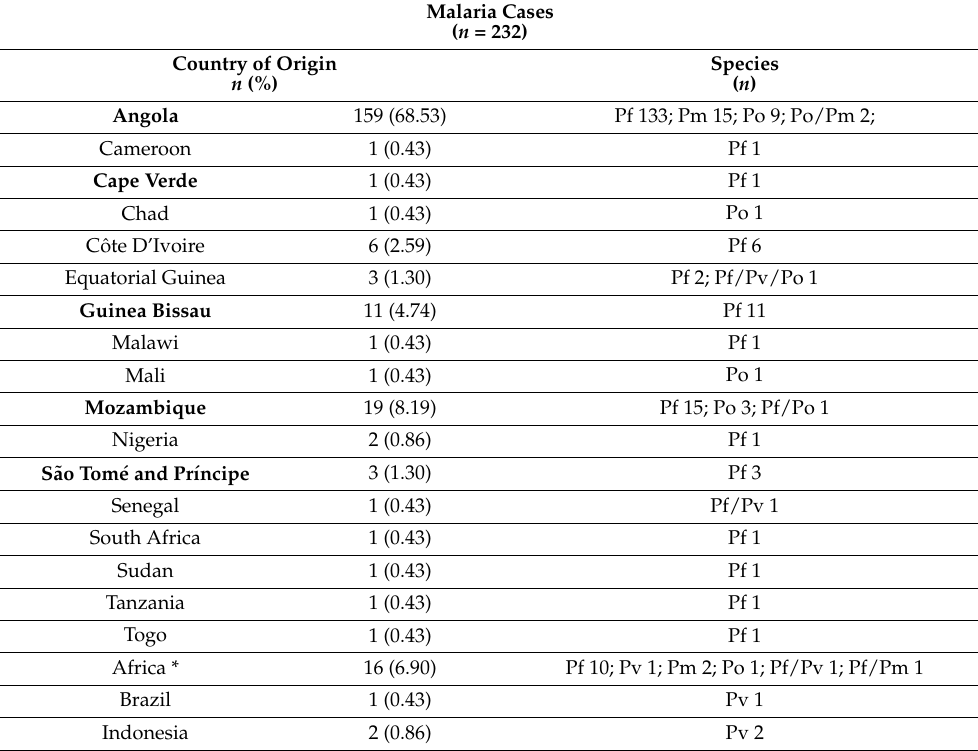
Table 1. Malaria imported cases diagnosed at IHMT and CHLO from 2014–2021 and geographical